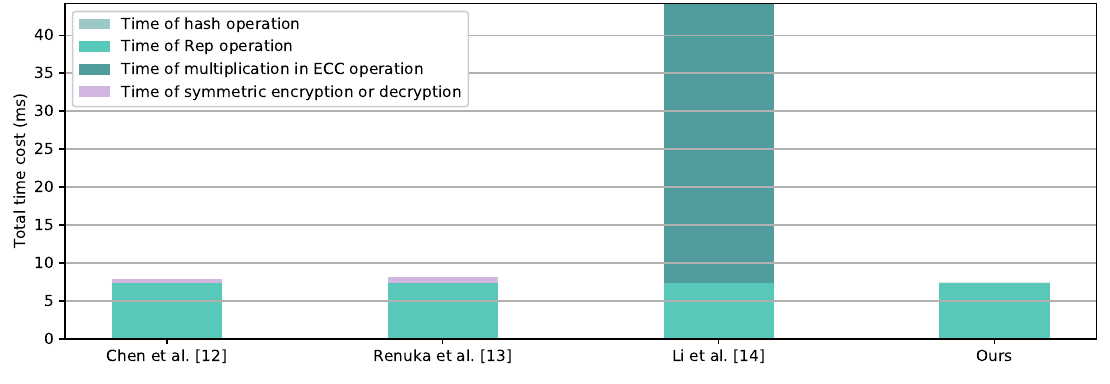
Figure 2. Execution Time of